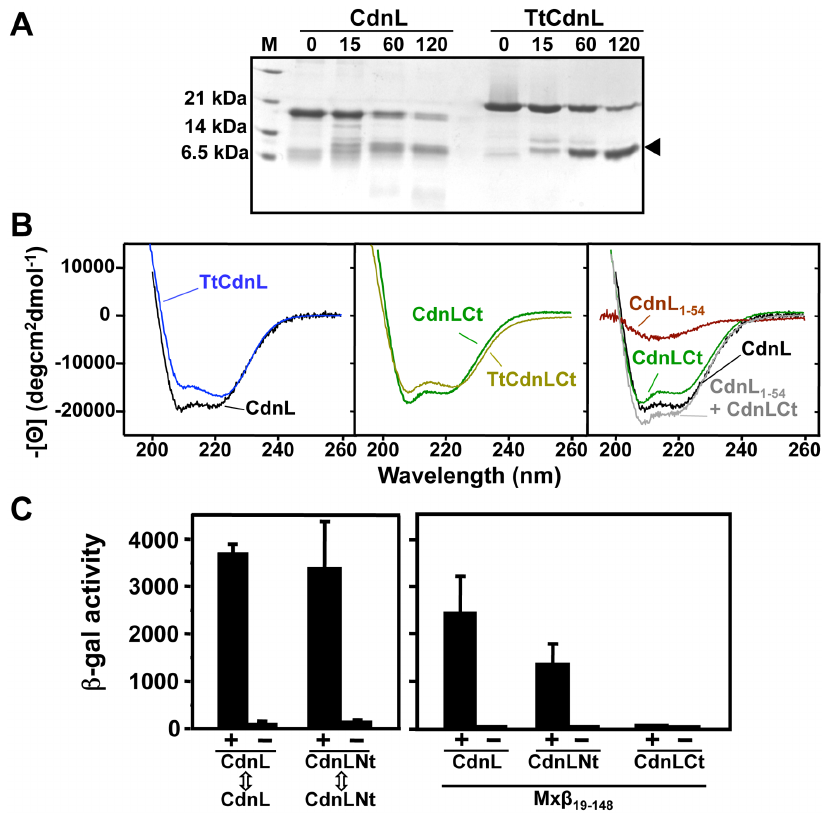
Figure 1. CdnL domain analysis. ( A ) Limited proteolysis of CdnL and TtCdnL. Aliquots of the reaction mix (1:100 w/w subtilisin:protein) at 30 u C were withdrawn at the times (in min) indicated on top and analyzed in Coomassie-stained 15% SDS-PAGE gels (lane ‘‘M’’: molecular weight markers). Arrowhead on the right points to the subtilisin-resistant fragment, which mass spectrometry and N-terminal sequencing identified as the , 100- residue C-terminal region in both proteins. Note the slower mobility of TtCdnL, whose size (164 residues) is the same as CdnL. ( B ) Far UV-CD spectra of CdnL, TtCdnL, and their indicated fragments. ( C ) BACTH analysis of the interactions of CdnL and its domains showing reporter lacZ expression in E. coli transformed with plasmids pKT25 and pUT18 bearing cdnL or the gene for CdnLNt (left panel); or with a pUT18C construct of the gene for Mx b 19– 148 and pKT25 with cdnL or its indicated fragments (right panel). pKT25 without insert was used in negative controls (‘‘ 2 ’’).